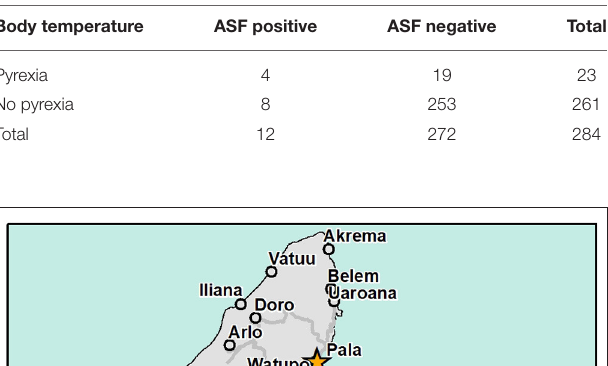
TABLE 3 | 2 × 2 risk table of pigs sampled for mainland prevalence and Atauro Island survey with or without pyrexia and ASF disease status.